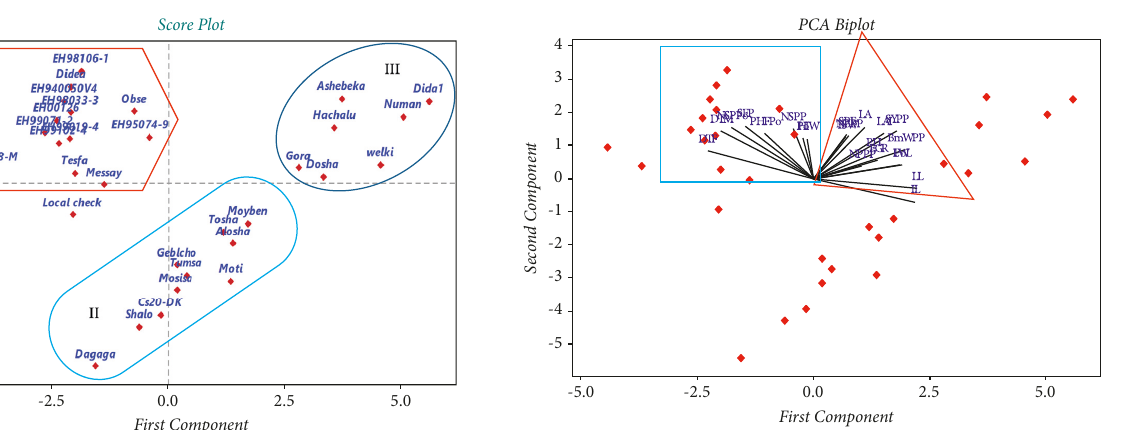
Figure 2: PCA Score plot showing the clustering pattern of the faba bean varieties considered in the present study.